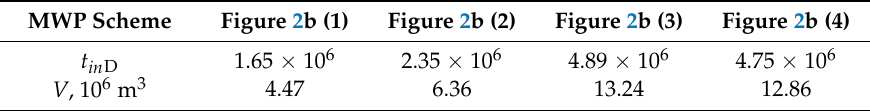
Figure 13. Illustration of pressure build-up curve ( q 1 : q 2 : q 3 = 1:2:3), P con = 7 MPa: ( a ) Figure 2b, Case 1; ( b ) Figure 2b, Case 2; ( c ) Figure 2b, Case 3; ( d ) Figure 2b, Case 4. Table 3. Comparison of different MWPs.